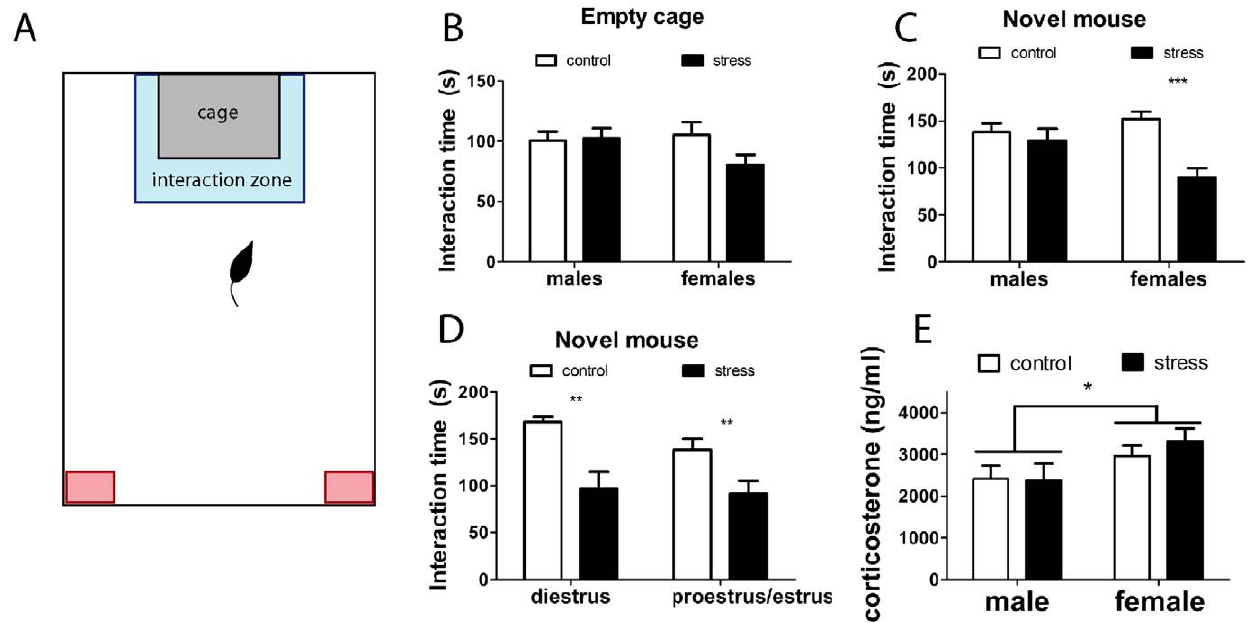
Figure 1. Social interaction behavior in male and female California mice four weeks after social defeat. In the apparatus used for testing (A), the interaction zone is indicated by a blue box and the corner zones indicated by red boxes. There were no significant differences when mice were tested with an empty cage (B). Females, but not males exposed to social defeat showed reduced social interaction behavior with a novel mouse (C). Immediately after the social interaction test mice were euthanized and vaginal lavage was conducted to determine estrous cycle stage. Social defeat reduced social interaction time at different stages of the estrous cycle (D). Corticosterone levels measured immediately after social interaction testing were higher in females compared to males (E). * main effect of sex p , 0.05, ** planned comparison control group versus stress group p , 0.01. *** planned comparison control group versus stress group p , 0.01. All data are mean 6 s.e.